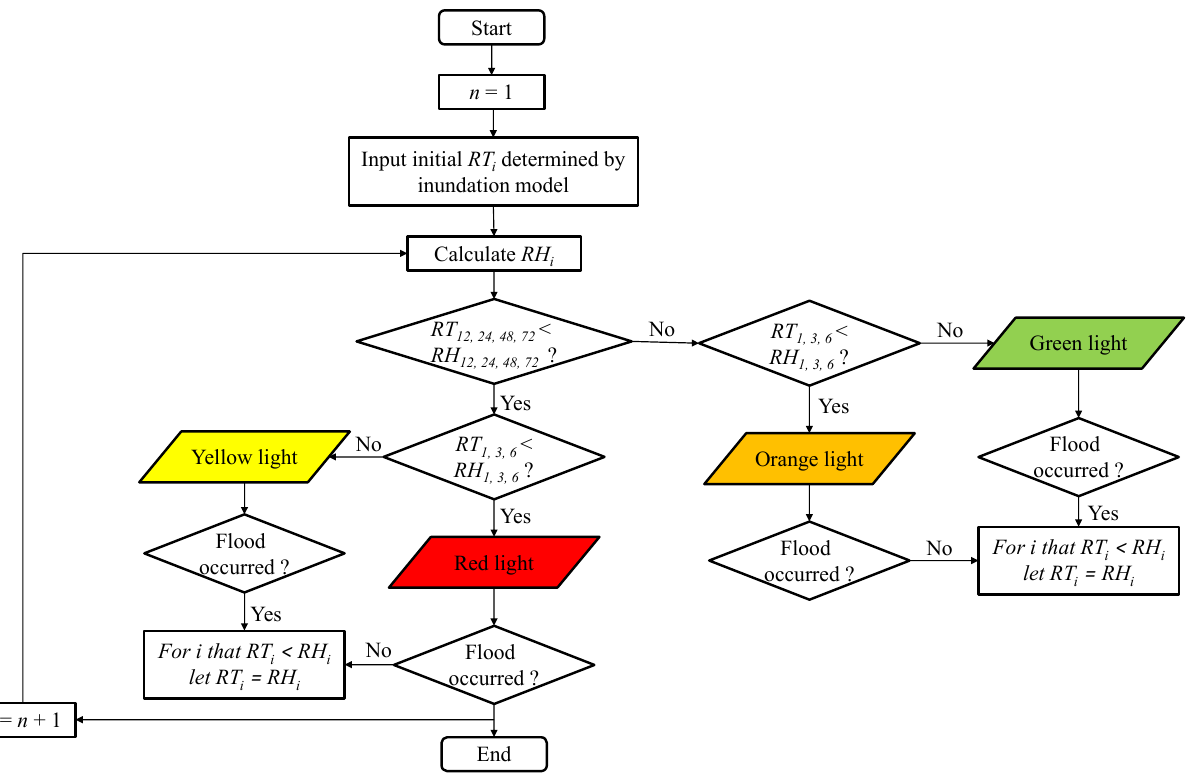
Figure 8. Workflow of updating and combing the rainfall thresholds to provide